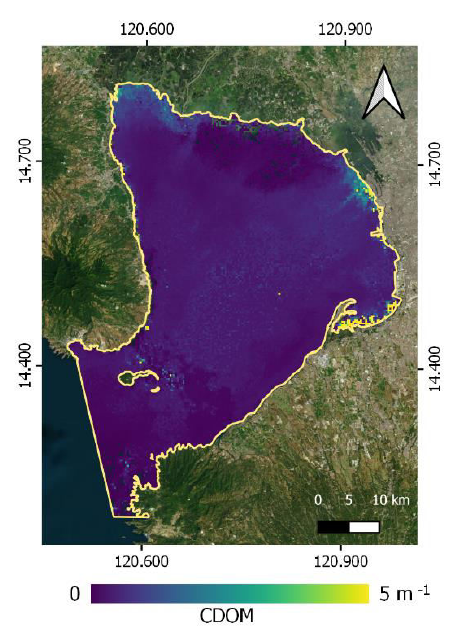
Figure 5. CDOM map using Sentinel-3 image from June